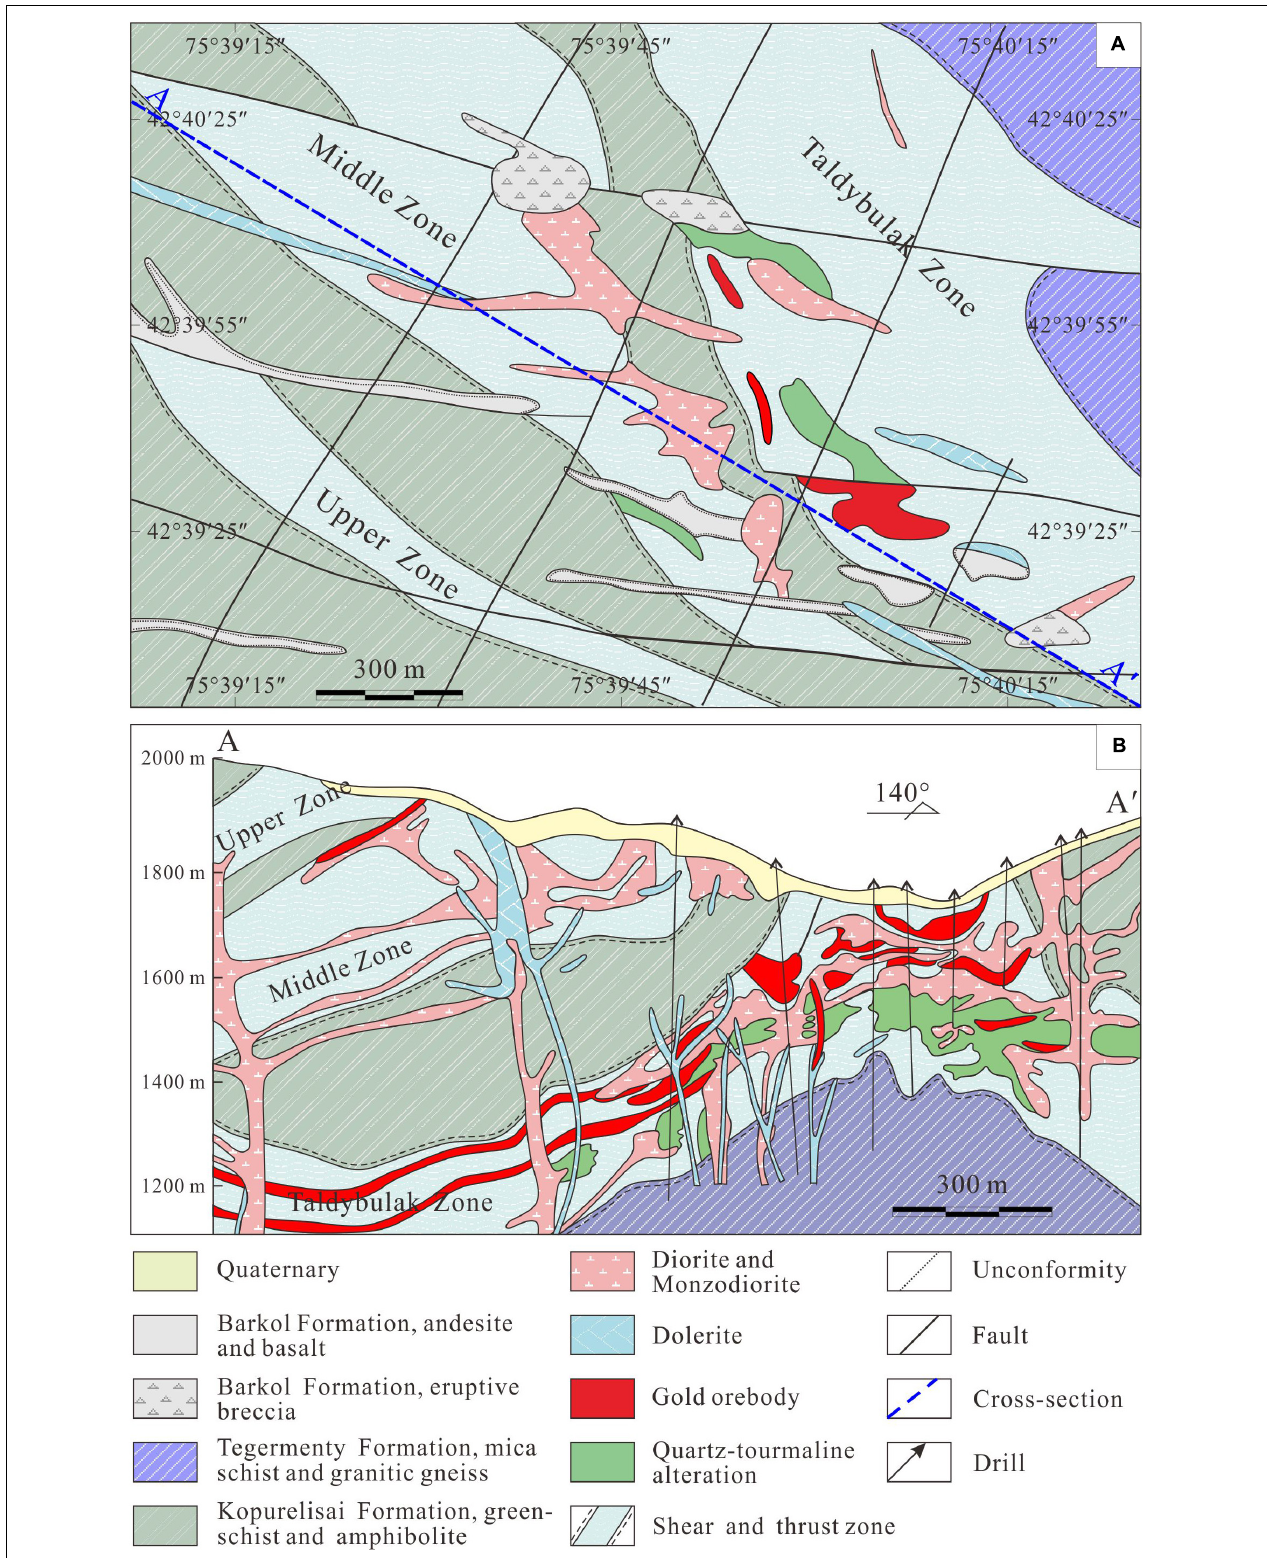
FIGURE 2 | Geological map (A) and a cross-section along A–A (cid:48) (B) of the Taldybulak Levoberezhny gold deposit, modified from Malyukova (2001) and Djenchuraeva et al. (2008).